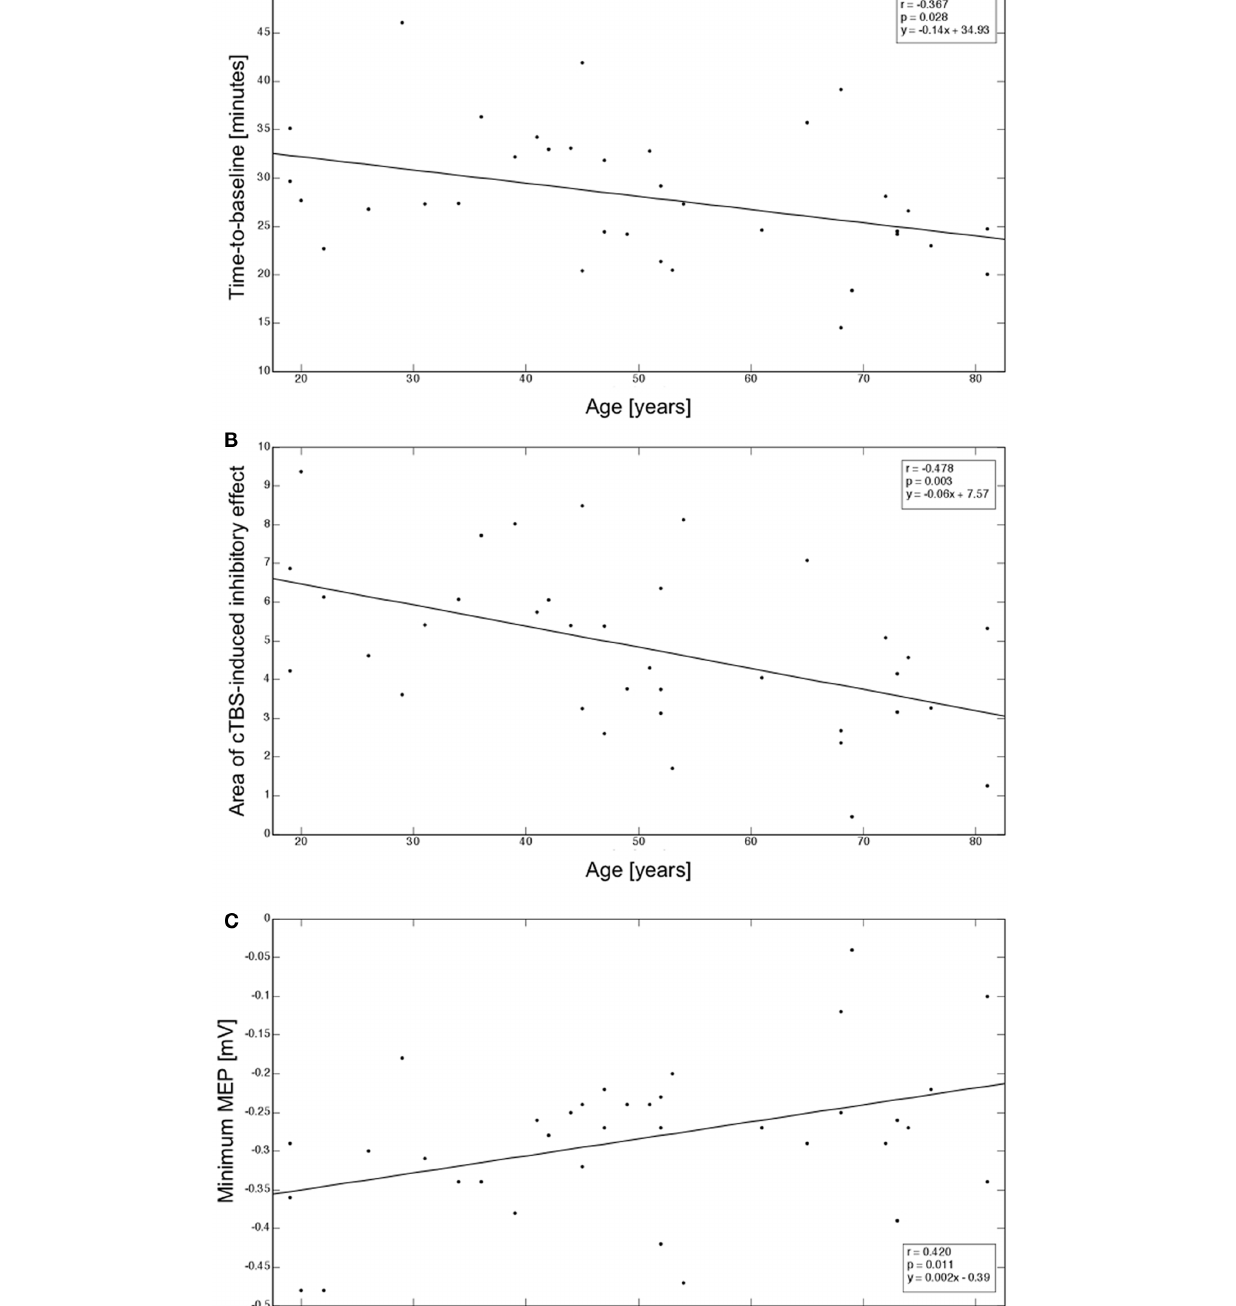
ioral measures of motor learning are important. The progressive decrease in cTBS-induced plasticity we found in the motor cortex with advancing age may indeed be associated with age- dependent